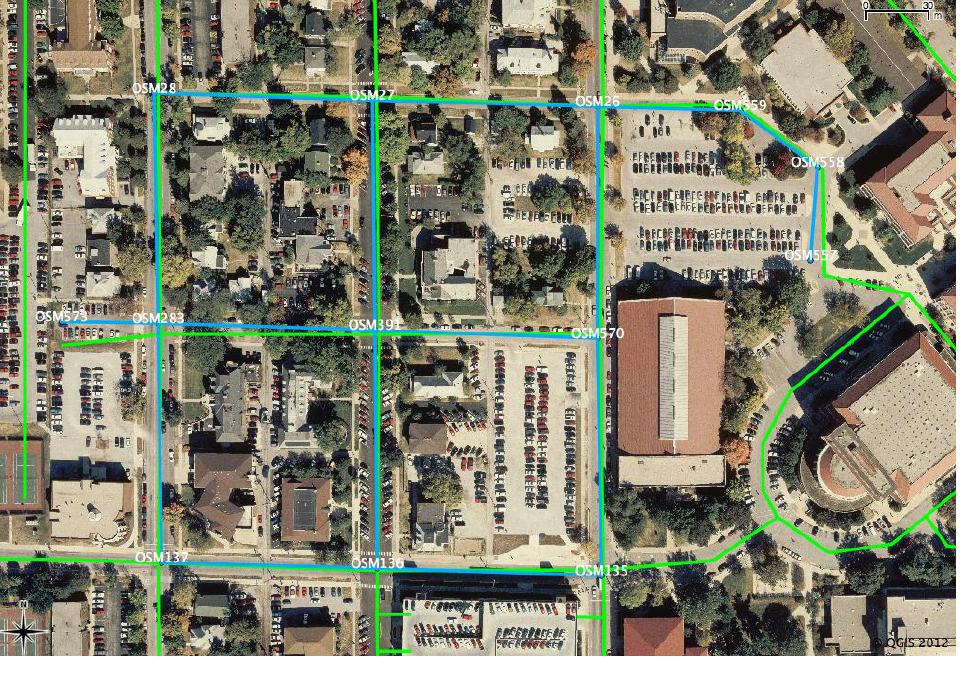
Figure 5. Close up area